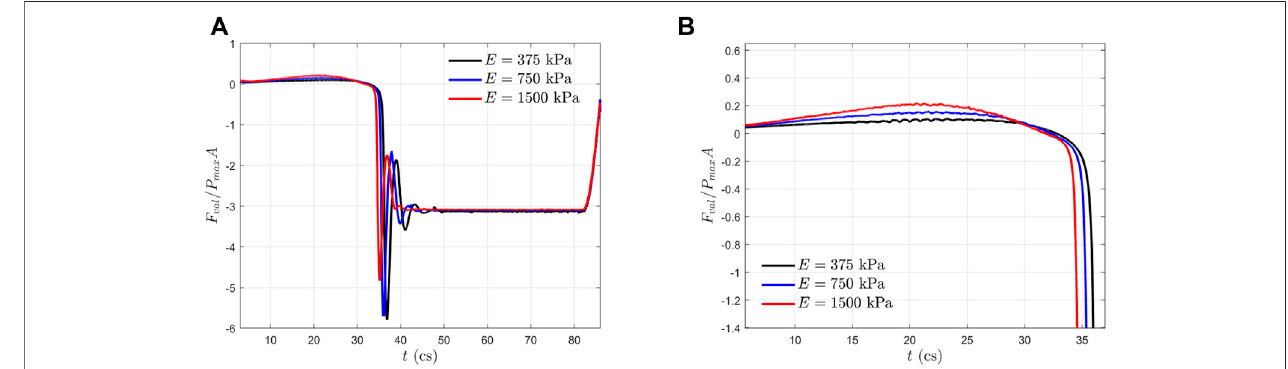
FIGURE 6 | (A) Normalized axial hemodynamic forces experienced by the aortic valves within one cardiac cycle; and (B) a zoom-in view of (A) during the systole